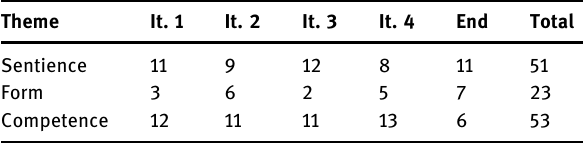
Table 3: Breakdown of comment theme versus which iteration the comment was written, or if it was written at the end of all iterations; some comments are counted in multiple themes